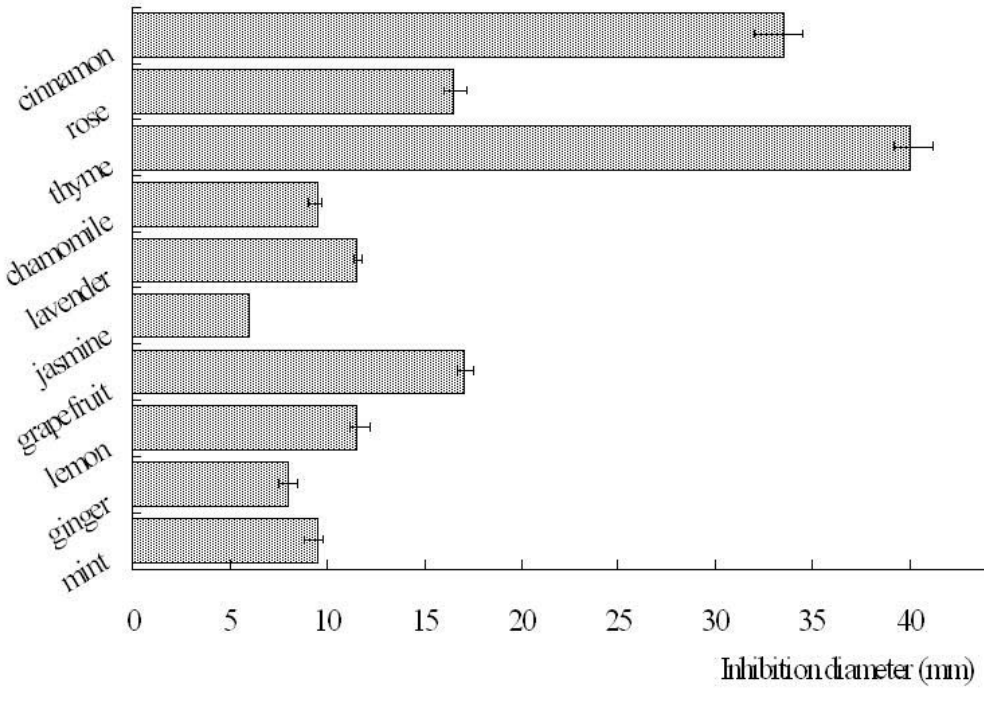
Figure 1 . Inhibition diameters of 10 essential oils towards P. acnes .